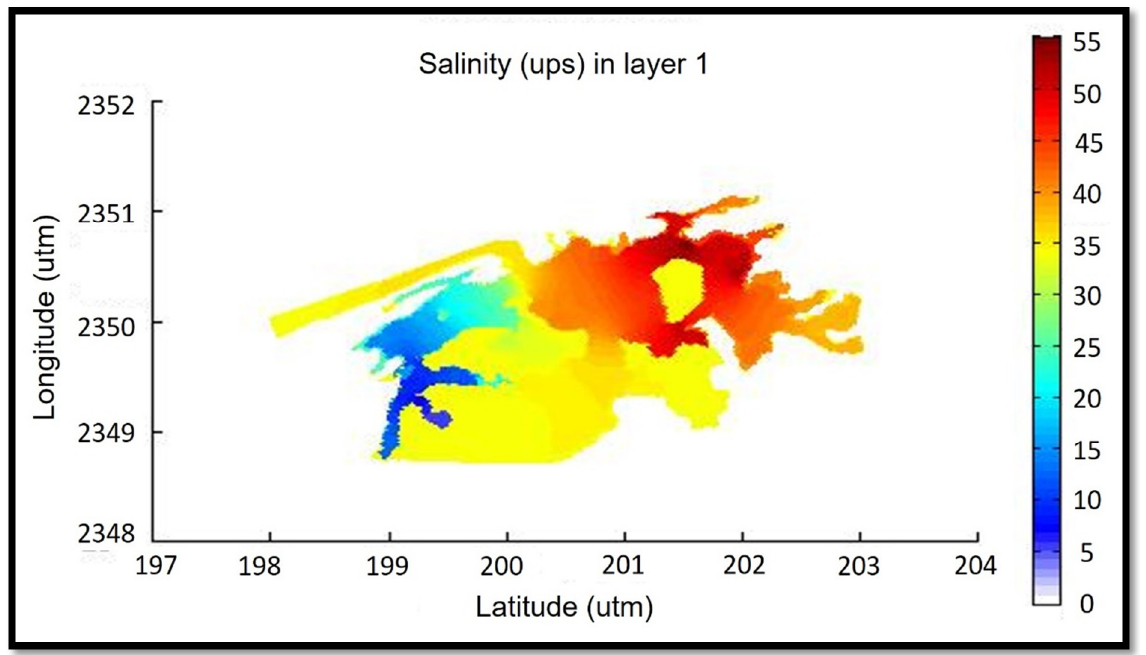
Figure A5. Example of salinity patterns in the La Carbonera lagoon. The hiperhaline zone can reach levels of over 80 ups [33] .